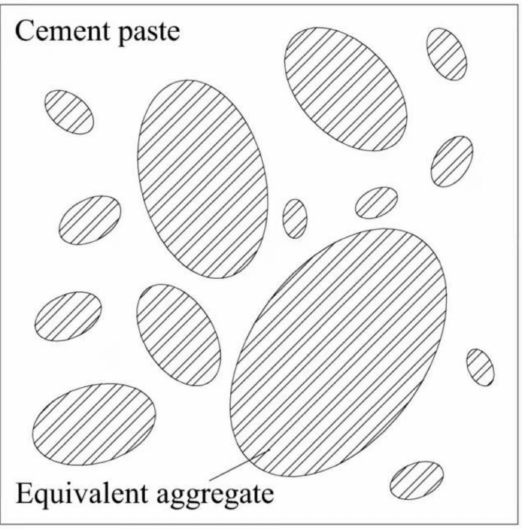
Figure 4. Two-phase concrete composed of bulk cement paste and equivalent